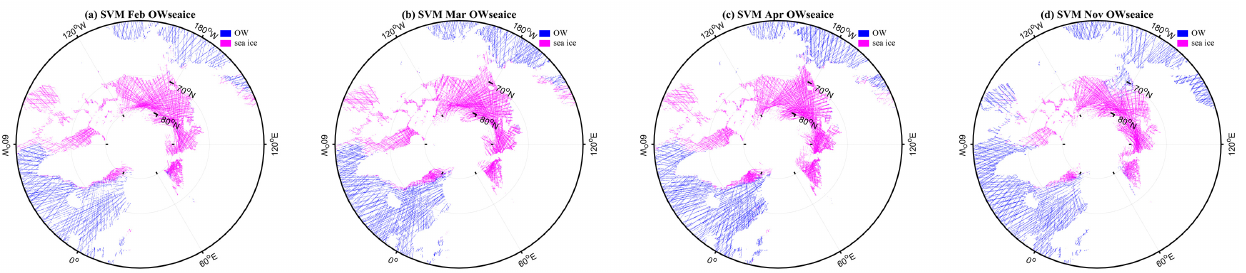
Figure A10. SVM for OW-sea ice classification using the data in December as the training set. The data in ( a ) February, ( b ) March, ( c ) April, and ( d ) November are used as the test set in turn.